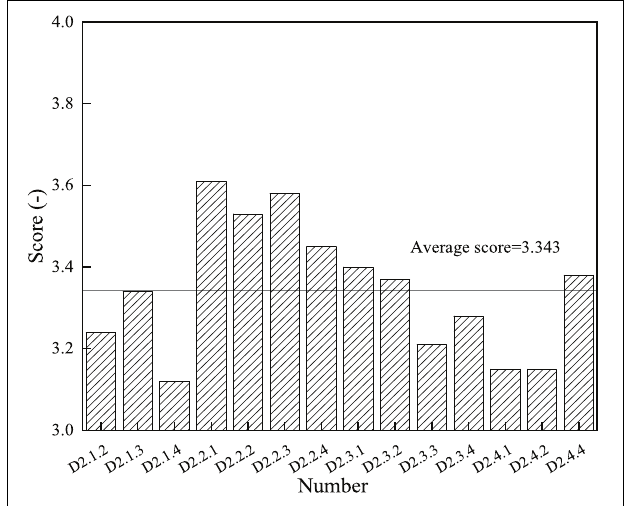
FIGURE 7 | Scores of each item in cultural diversity cultivation.